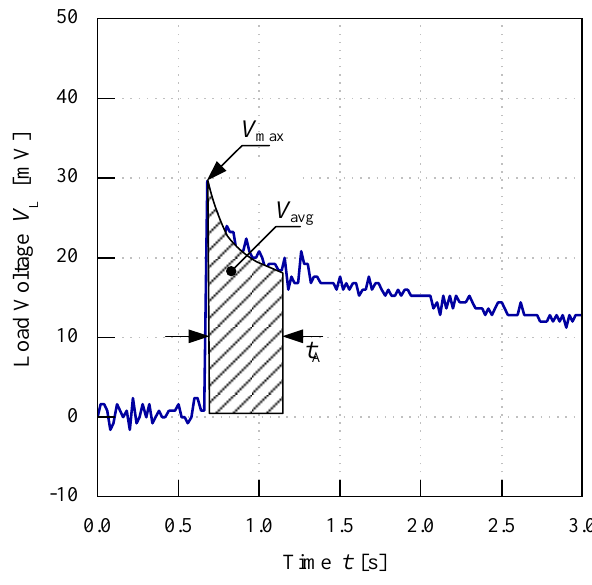
Figure 9. Methods to characterize load resistance voltage readings.